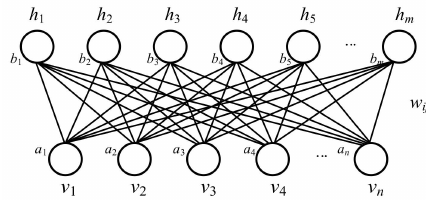
Figure 2. Structure of a Restricted Boltzmann Machine